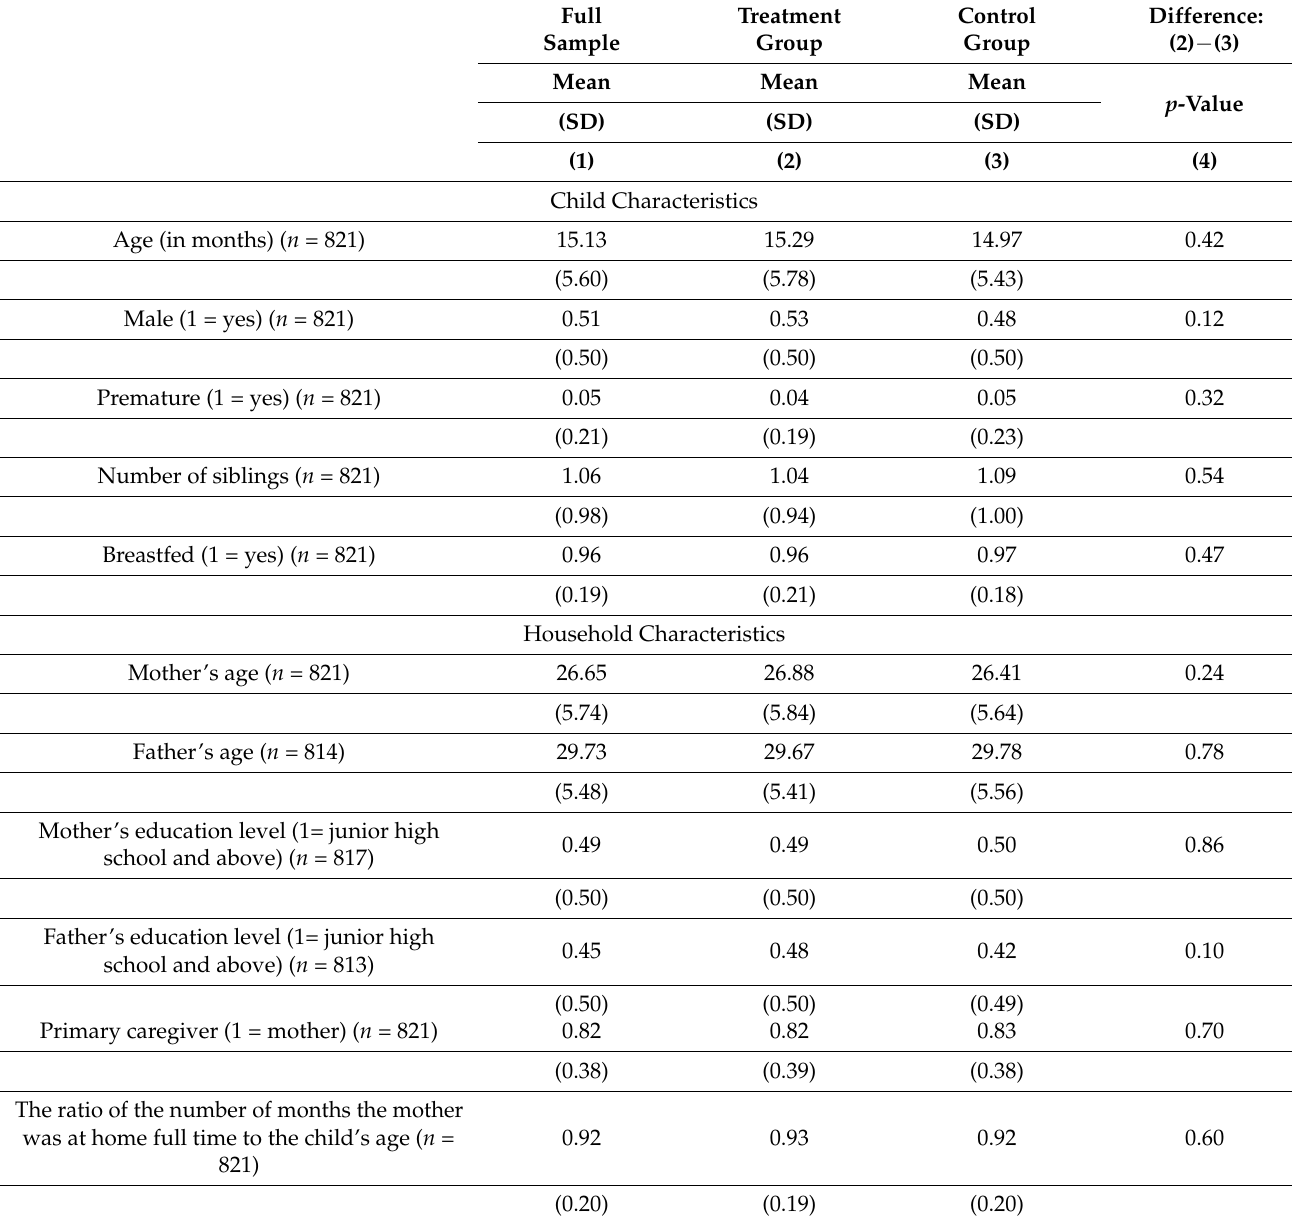
Table A1. Balance test of the remaining sample after both attrition and